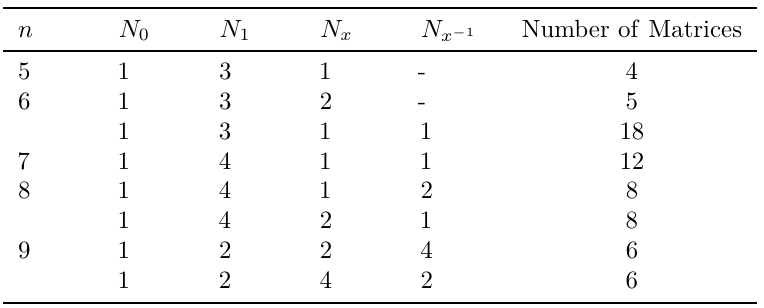
Table 1: Optimal parameters with maximum N 1 and minimum N x + N